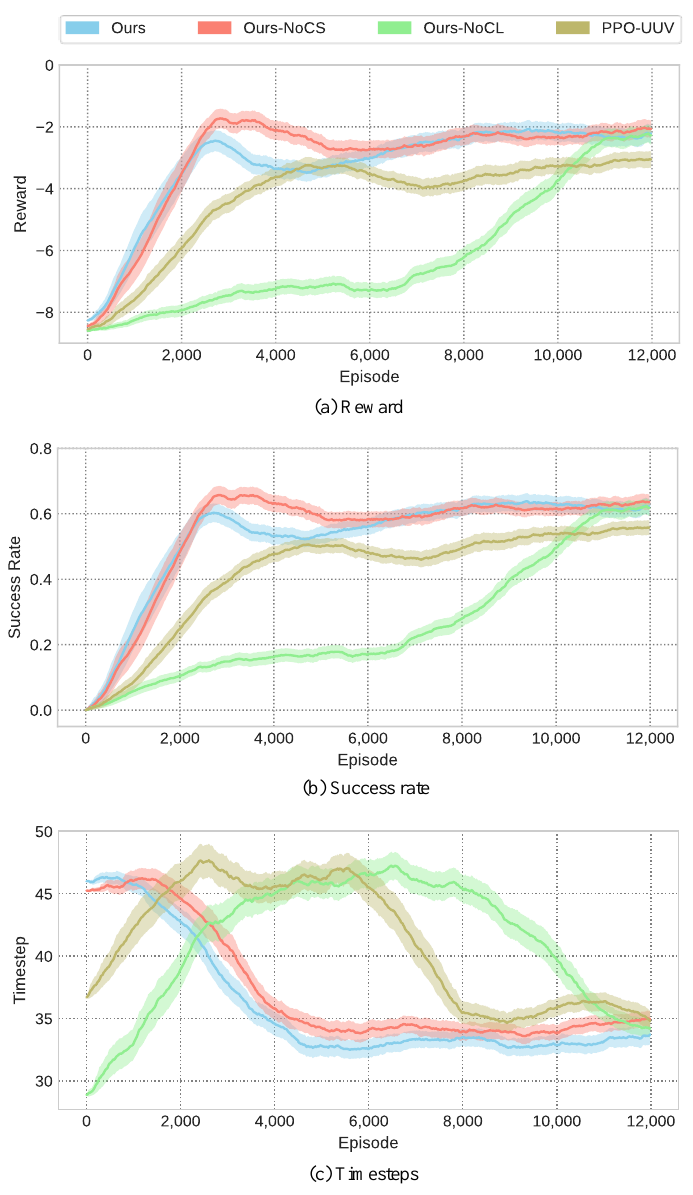
Figure 7. Convergence curves of Ours, Ours-NoCS, Ours-NoCL, and PPO-UUV. For clarity, we made a sliding average of all curves, and the transparent area of each curve represents the confidence interval of